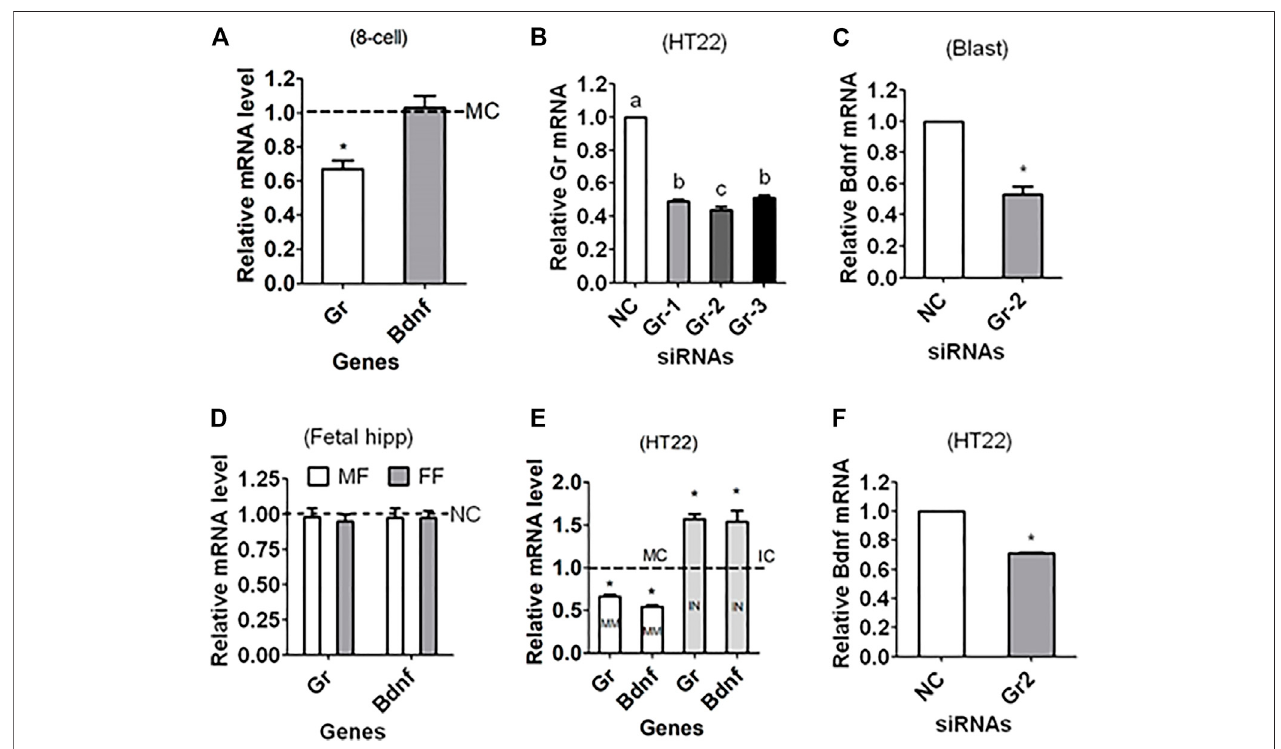
FIGURE 5 | Regulating Gr and Bdnf expression in mouse preimplantation embryos and HT22 hippocampal neuron line using miR-211 mimics or Gr siRNA. (A) RelativelevelsofGrandBdnfmRNAsin4-to8-cellembryosrecoveredat48 hofcultureinCZBwithoutcorticosteronefollowingmicroinjectionofzygoteswithmiR-211- 5p mimic negative control (MC) or mimics. (B) Relative levels of Gr mRNA in HT22 cell line following transfection with NC siRNA, Gr-siRNA1 (Gr-1), Gr-siRNA2 (Gr-2) or Gr-siRNA3 (Gr-3). (C) Relative level of Bdnf mRNA in blastocysts following microinjection of zygotes with NC or Gr-2 siRNA. (D) Relative levels of Gr and Bdnf mRNAs in male (MF) and female fetal (FF) hippocampus after injection of zygotes with NC siRNA or Gr-2 siRNA. (E) Relative levels of Gr and Bdnf mRNAs in HT22 cells following transfection with miR-211-5p mimic or inhibitor negative control (MC or IC) or mimics (MM) or inhibitors (IN). (F) Relative level of Bdnf mRNA in HT22 cells following transfection with NC or Gr-2 siRNA. For embryo experiments in graphs (A,C) , each treatment was repeated three times with each replicate containing 60 embryos; for HT22 experiments in graphs (B,E,F) , each treatment was repeated three times with each replicate including cells from one well of a 24-well plate; and